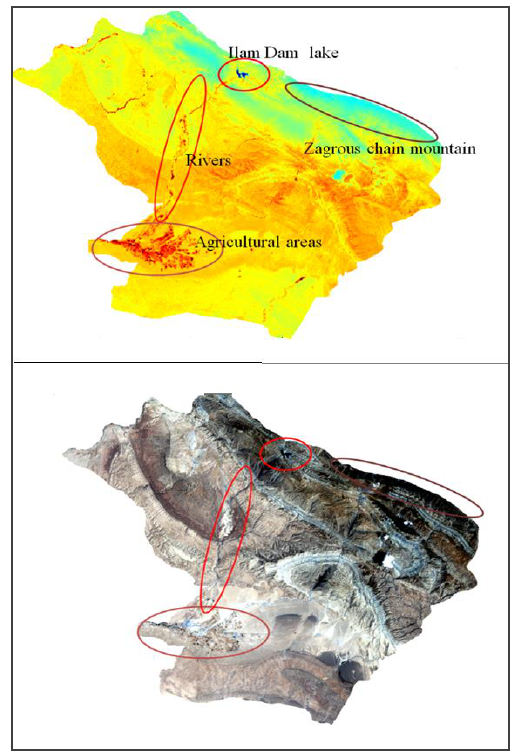
Figure 7. Compariton of risk map of Mehran with it's Satellite